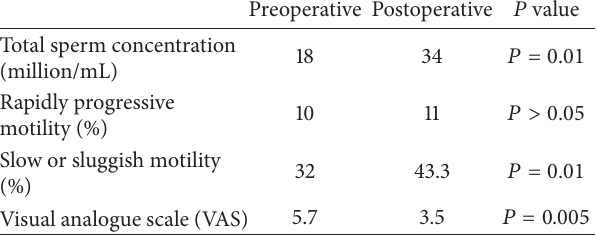
Table 1: Preoperative and postoperative values of total sperm concentration (TSC), rapidly progressive motility (SPa), slow or sluggish motility (SPb), and 10cm visual analogue scale (VAS) in Group-1.